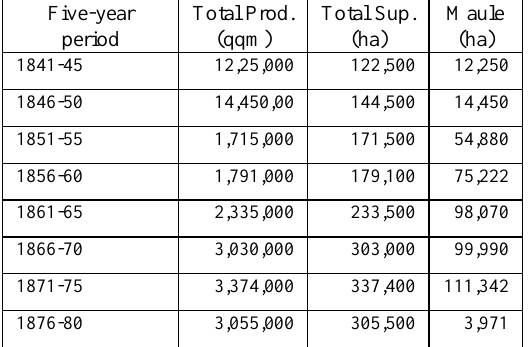
Table 1. Mean yearly production of wheat in Chile and Maule Valley (from Bauer, 1975). 1 quintal (qqm) = 100 kg.